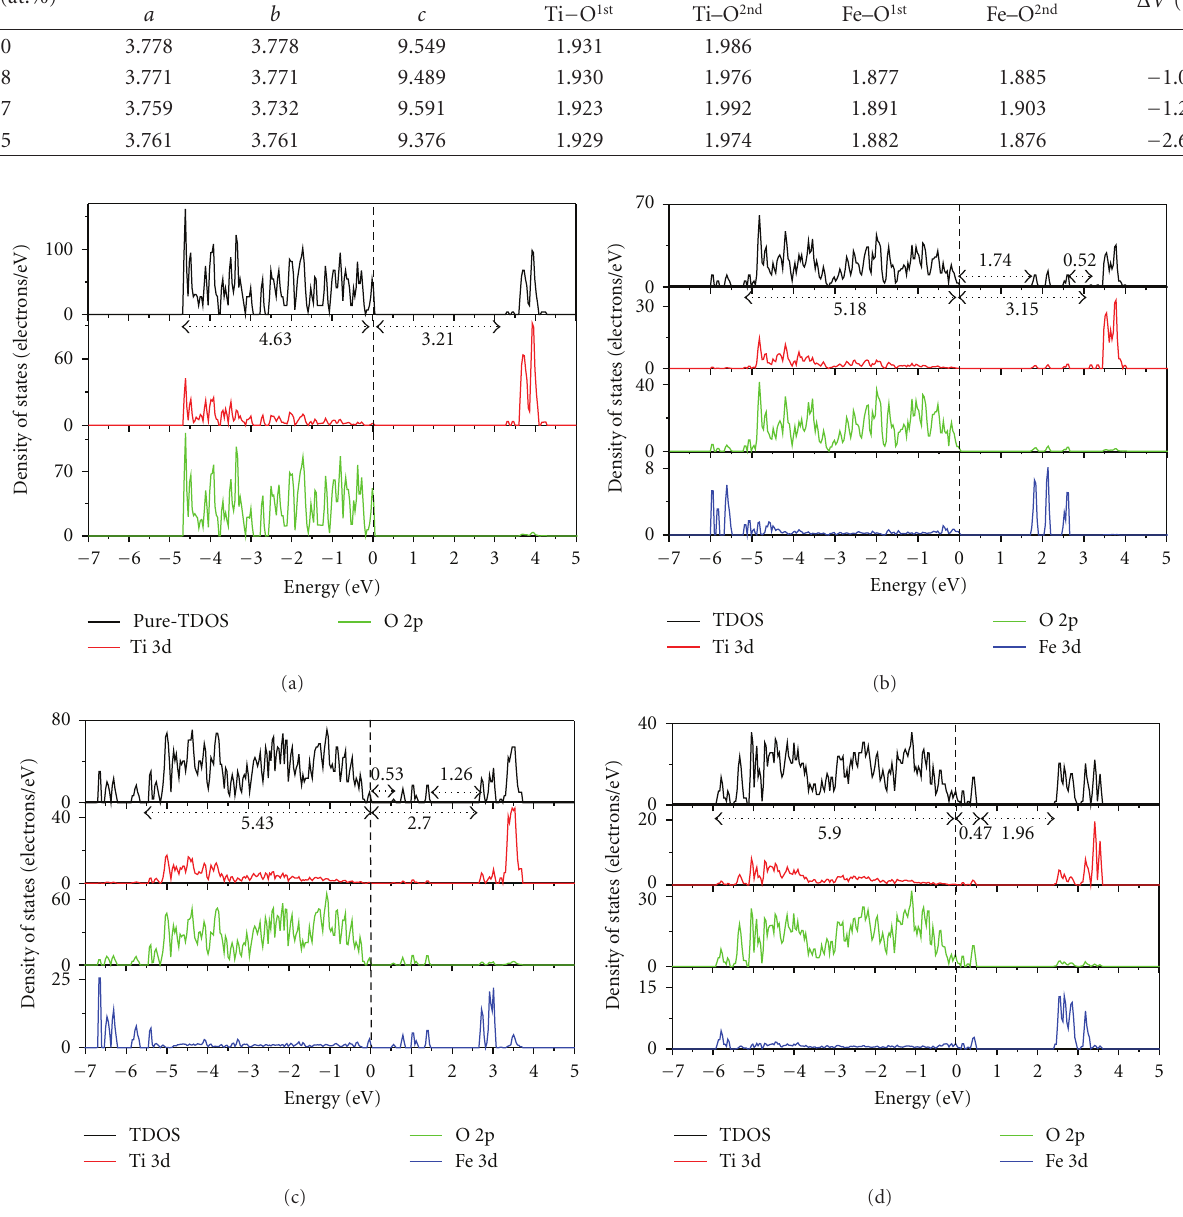
Figure 3: Density of states (DOS) of TiO 2 doped with Fe (a) 0 at.%, (b) 2.08 at.%, (c) 4.17 at.%, (d) 6.25 at.%. The vertical dotted line is the Fermi energy